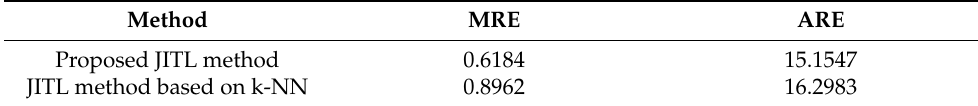
Figure 12. RUL prediction of gear pump 4 predicted by JITL method based on k-NN. Table 8. Comparison of MRE and ARE of both methods.